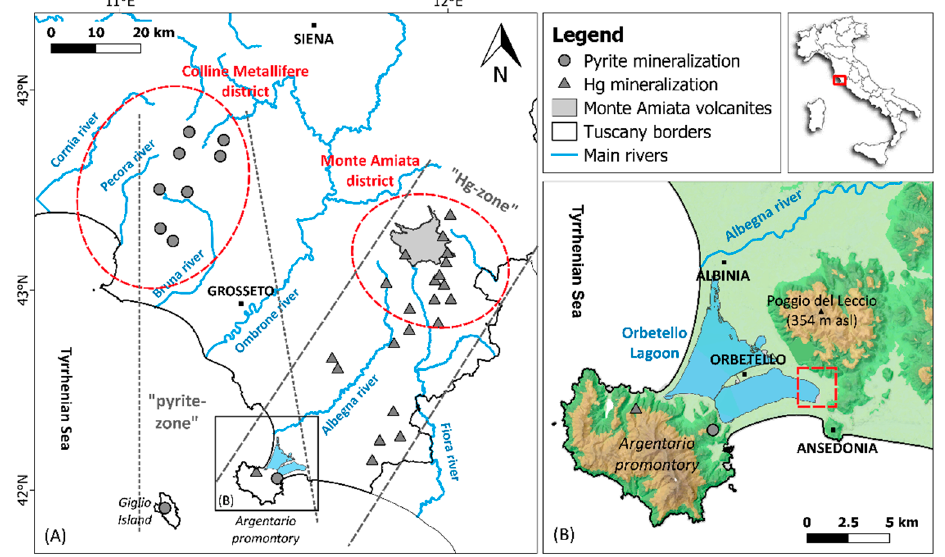
Figure 1. ( A ) Schematic map showing the location of the main Hg-and pyrite-rich mineralization of southern Tuscany and the outlined “Hg- and pyrite-zone” [26,29,30,36,56]. The red circles point out the Monte Amiata and Colline Metallifere districts, which include the major ore deposits. Figure ( B ) shows the Orbetello Lagoon and the study area (red square). The background is a classified digital elevation model (DEM 10 × 10) of Tuscany available on the regional portal “GEOscopio” (https://www502.regione.toscana.it/geoscopio/cartoteca.html).